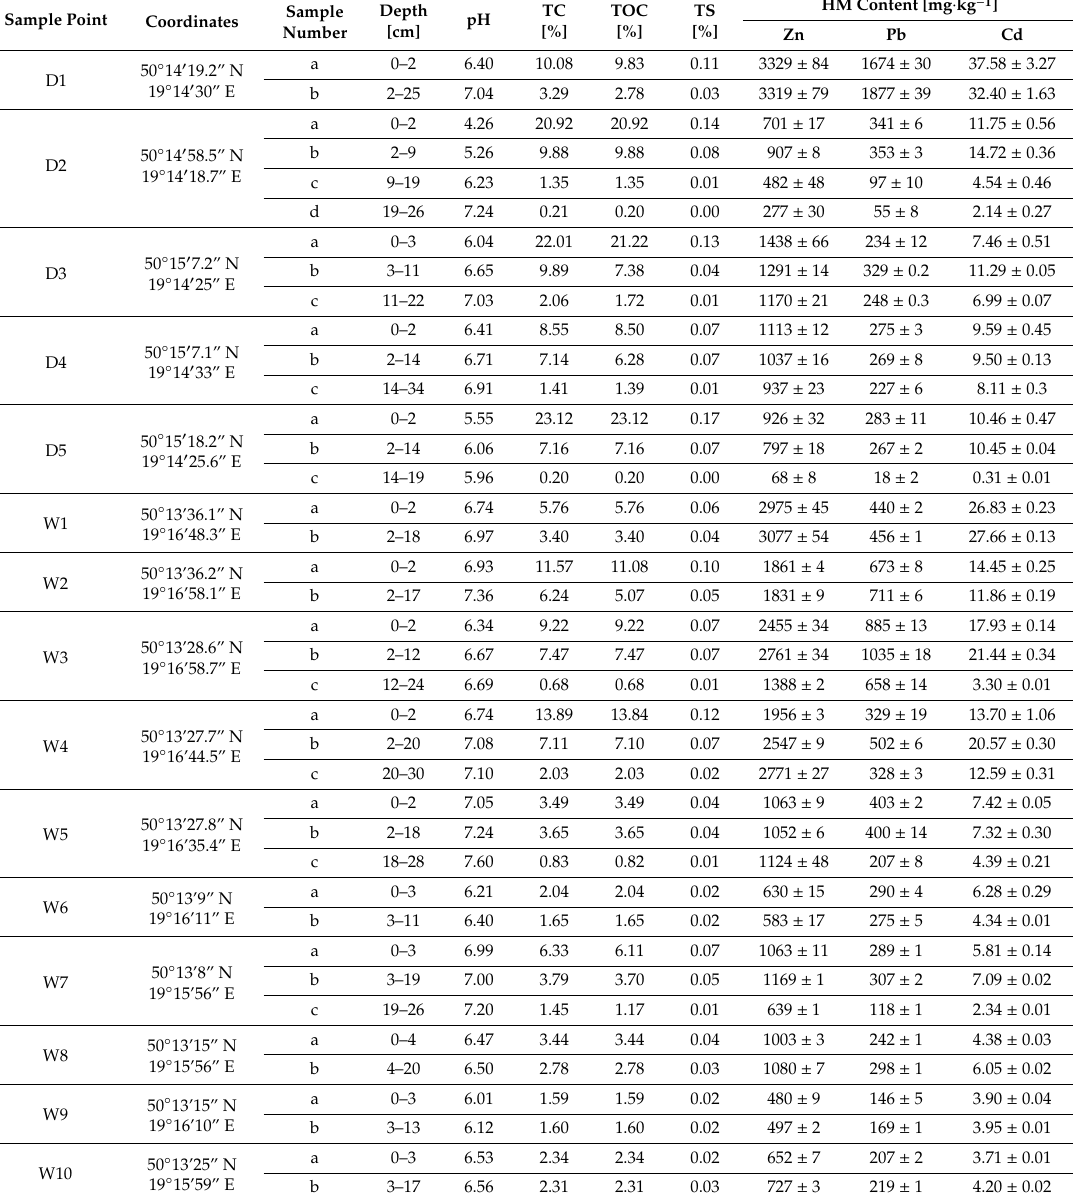
Table 1. Geochemical properties of the topsoil samples. D—Dlugoszyn area, W—Wilkoszyn area. Sample